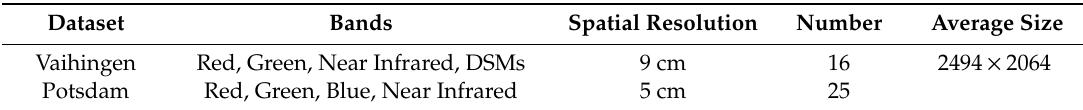
Table 2. Dataset parameters.